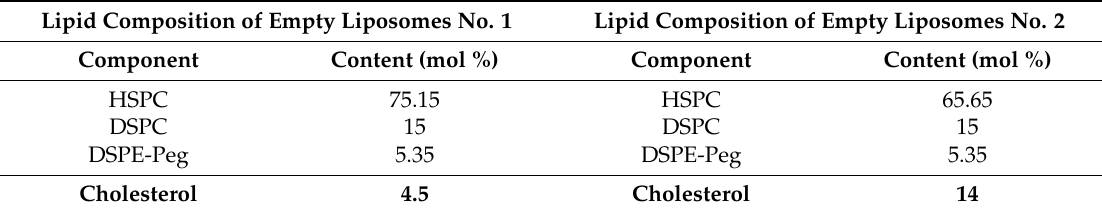
Table 2. Lipid compositions of tested empty liposomes.